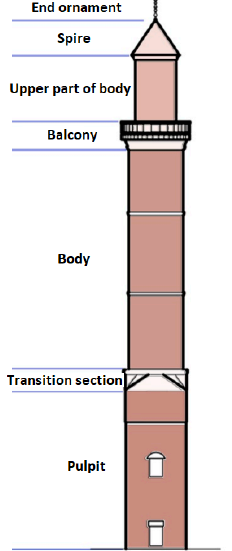
Figure 2. Parts of the minaret chosen as an example.